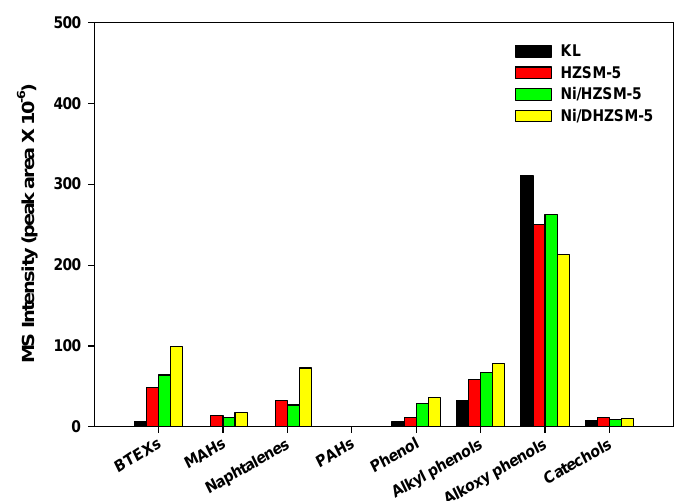
Figure 4. Summed MS peak areas for each chemical groups obtained from the CP of KL over different catalysts. (BTEXs: benzene, toluene, ethylbenzene, and xylenes; MAHs; other mono-aromatic hydrocarbons; PAHs; Other poly-aromatic hydrocarbons).